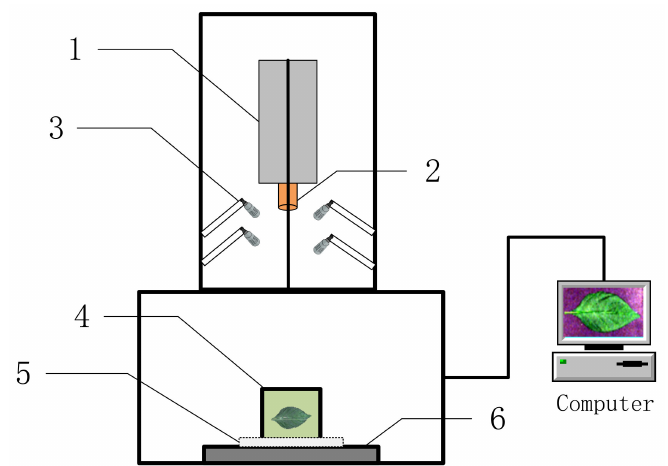
Figure 3. Schematic diagram of the GaiaSorter hyperspectral imaging system. 1. Hyperspectral imager, 2. imaging lens, 3. halogen lamp, 4. sample table, 5. correction whiteboard, and 6. electric translation table.